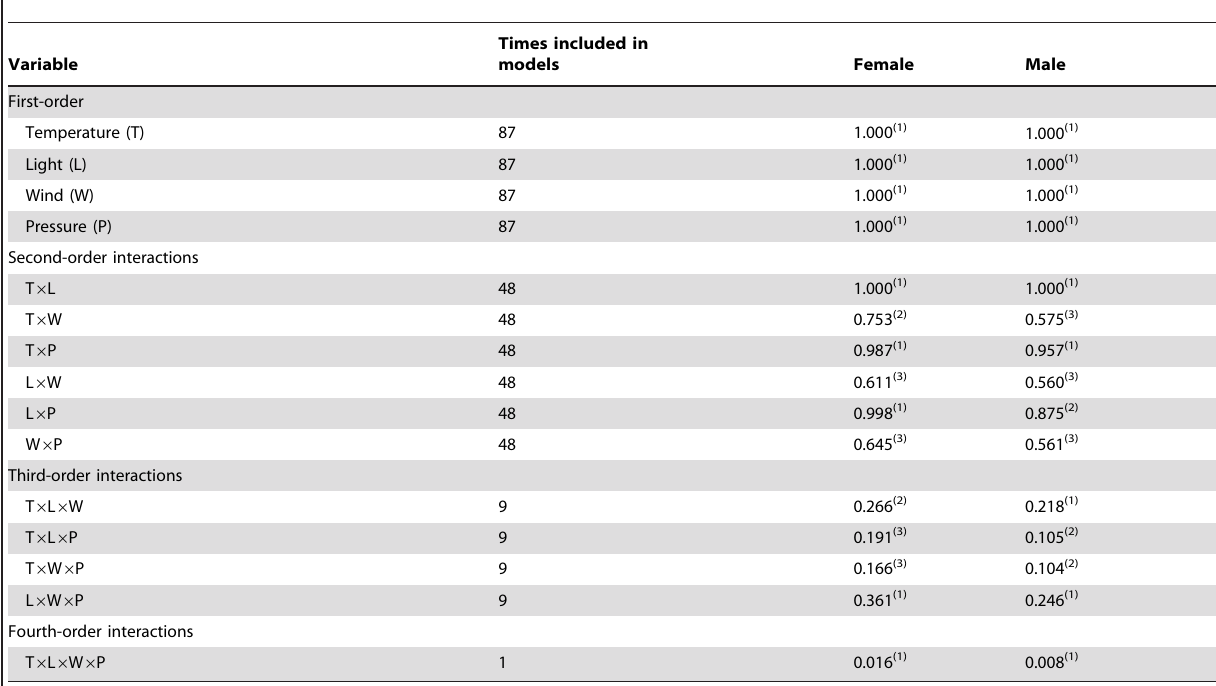
Table 3. Sum of w i (an indicator of relative importance in the model) for variables (terms) from selection of models predicting flight of Pityophthorus juglandis in response to ambient temperature (T), light intensity (L), wind speed (W), and barometric pressure (P) and their interactions.